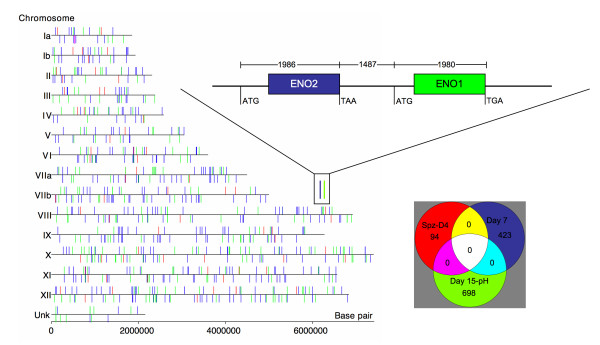
Chromosome landscape of mRNA expression in Toxoplasma. SAGE tag distribution with respect to three classes of co-regulated mRNAs are indicated in each chromosome assembly [32]; sporozoite- (red), Day-7 (blue) and Day-15/pH-shift (green) specific. Transcriptional orientation for each tag plotted is indicated by the up (forward) or down (reverse) direction of the corresponding mark. Inset Venn diagram shows the overall number of unique tags represented and demonstrates that there is no overlap in the expression of these classes of mRNA. The expanded diagram demonstrates the differentiation expression of the tandem head-to-tail sequences encoding enolase 1 and 2.